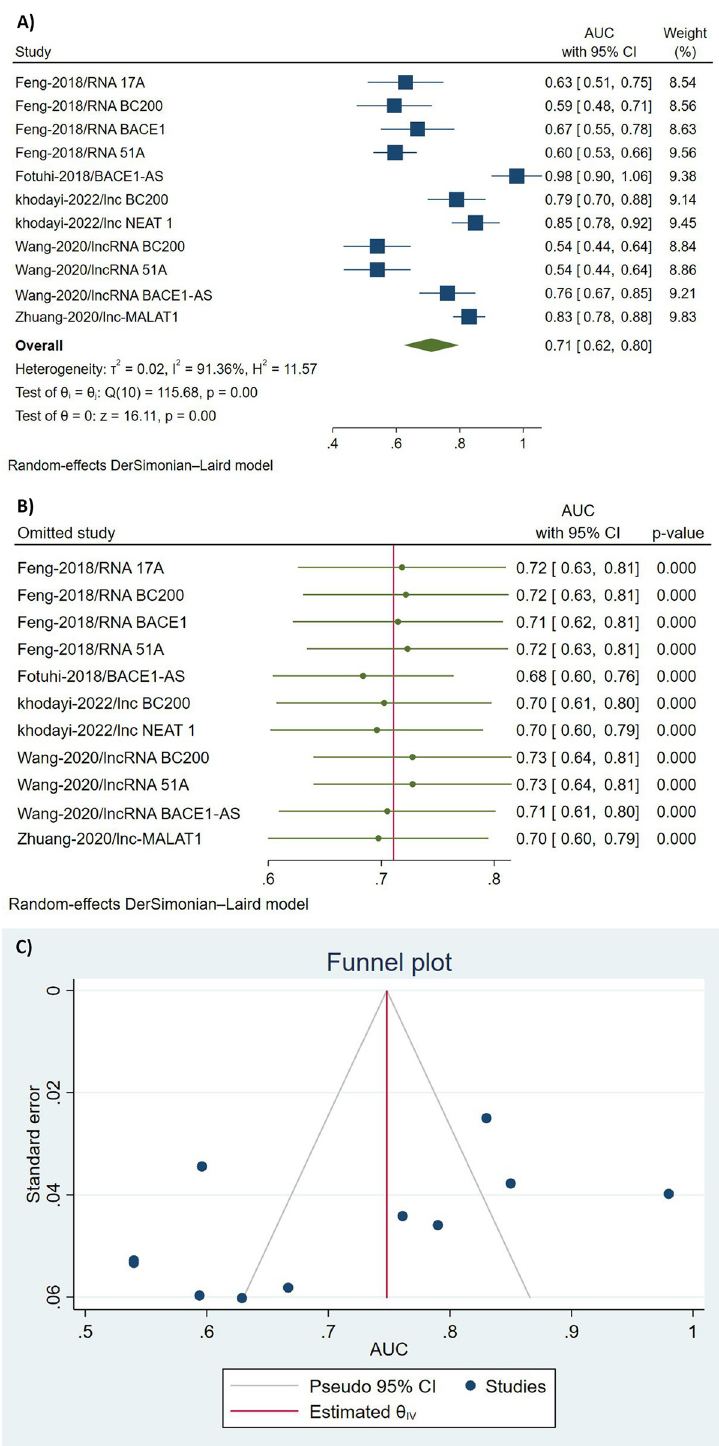
Fig 3. Meta-analysis of diagnostic accuracy of lncRNAs in AD vs. HCs (AUC). A: Forest Plot. B: Leave-one-out analysis. C: Funnel Plot.